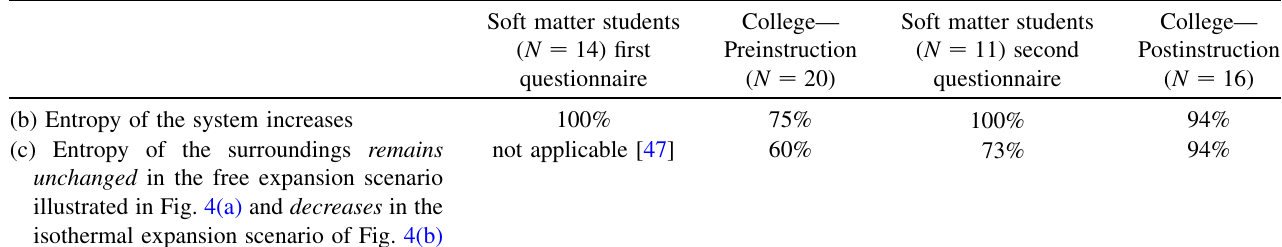
TABLE IV. A comparison of student correct answers to the ideal gas problem.